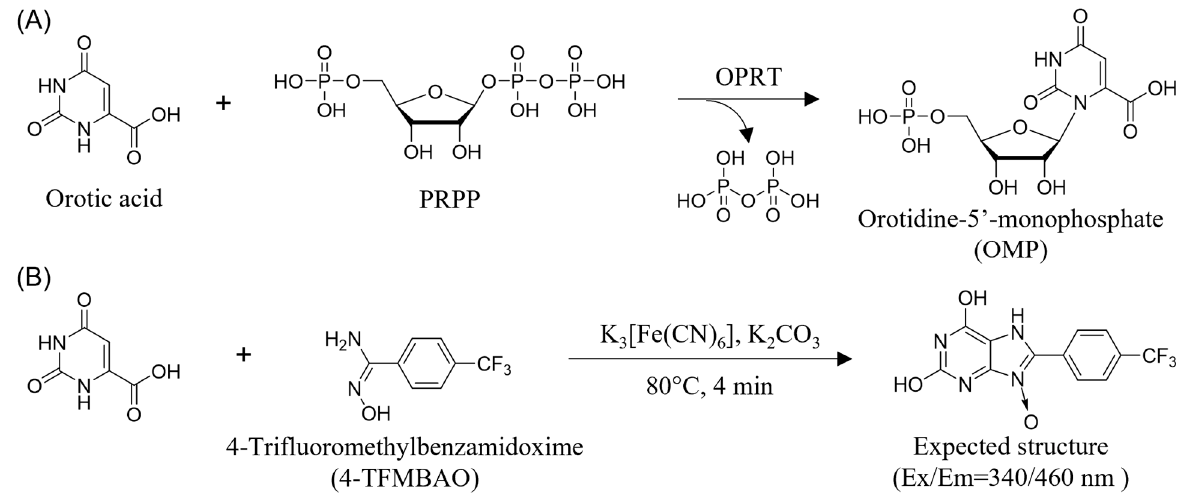
Figure 1. ( A ) The biosynthetic reaction from orotic acid and PRPP to OMP catalyzed by OPRT. ( B ) The fluorogenic reaction specific for orotic acid using 4-TFMBAO.